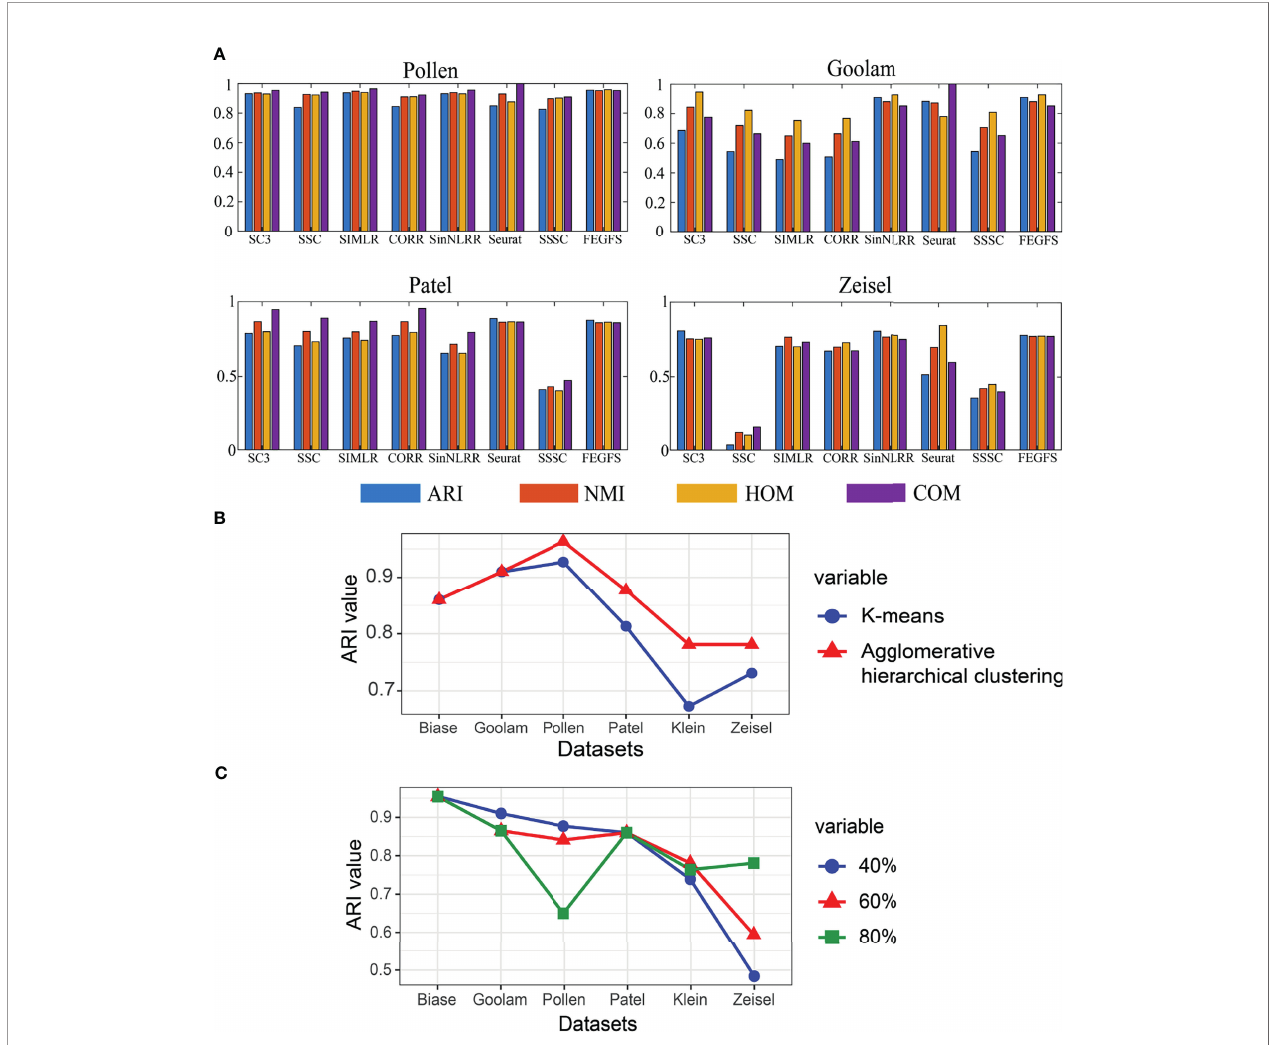
FIGURE 2 | (A) The clustering effect comparison of SC3, SSC, SIMLR, CORR, SinNLRR, Seurat, SSSC, and S3C2 on four datasets. (B) Line graph of retention rate based on adjusted Rand index (ARI). (C) Comparison of ARI values between K-means and agglomerative hierarchical clustering based on